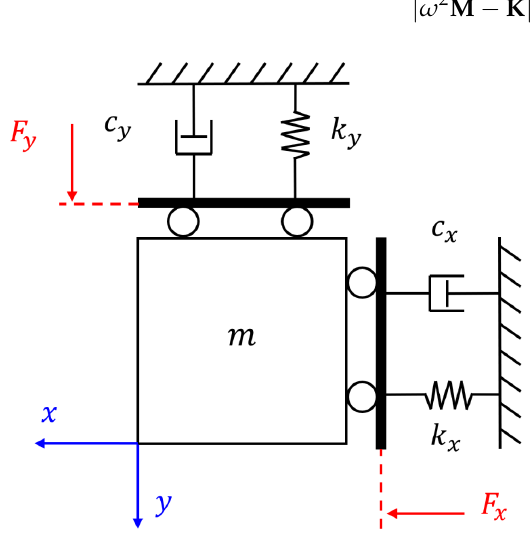
Figure 4. The schematic diagram of the dynamic model of the mechanism.